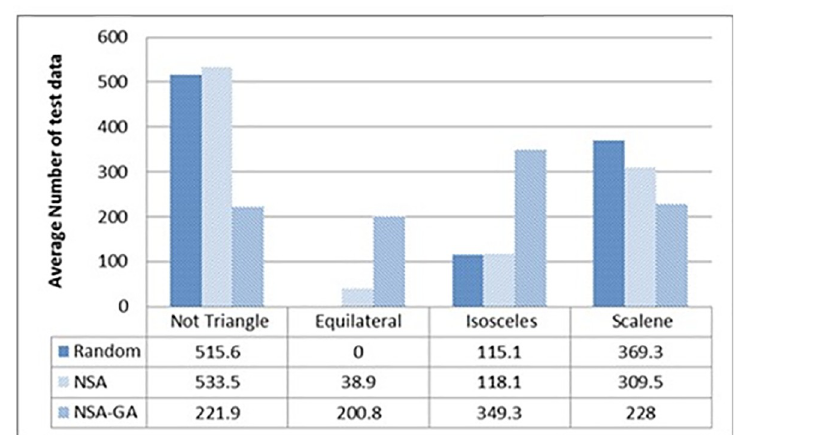
Fig 6. Average amount of test data to fulfill each path of TriTyp program.